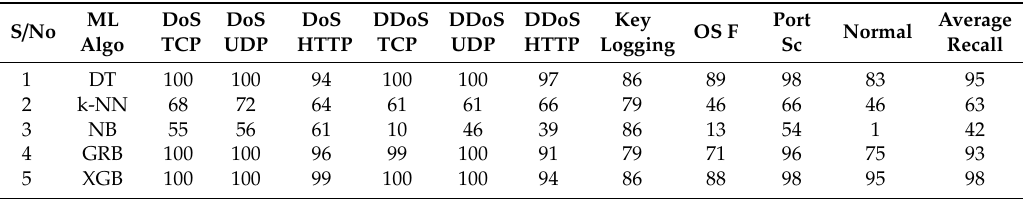
Table 9. Recall summary of the multiclass